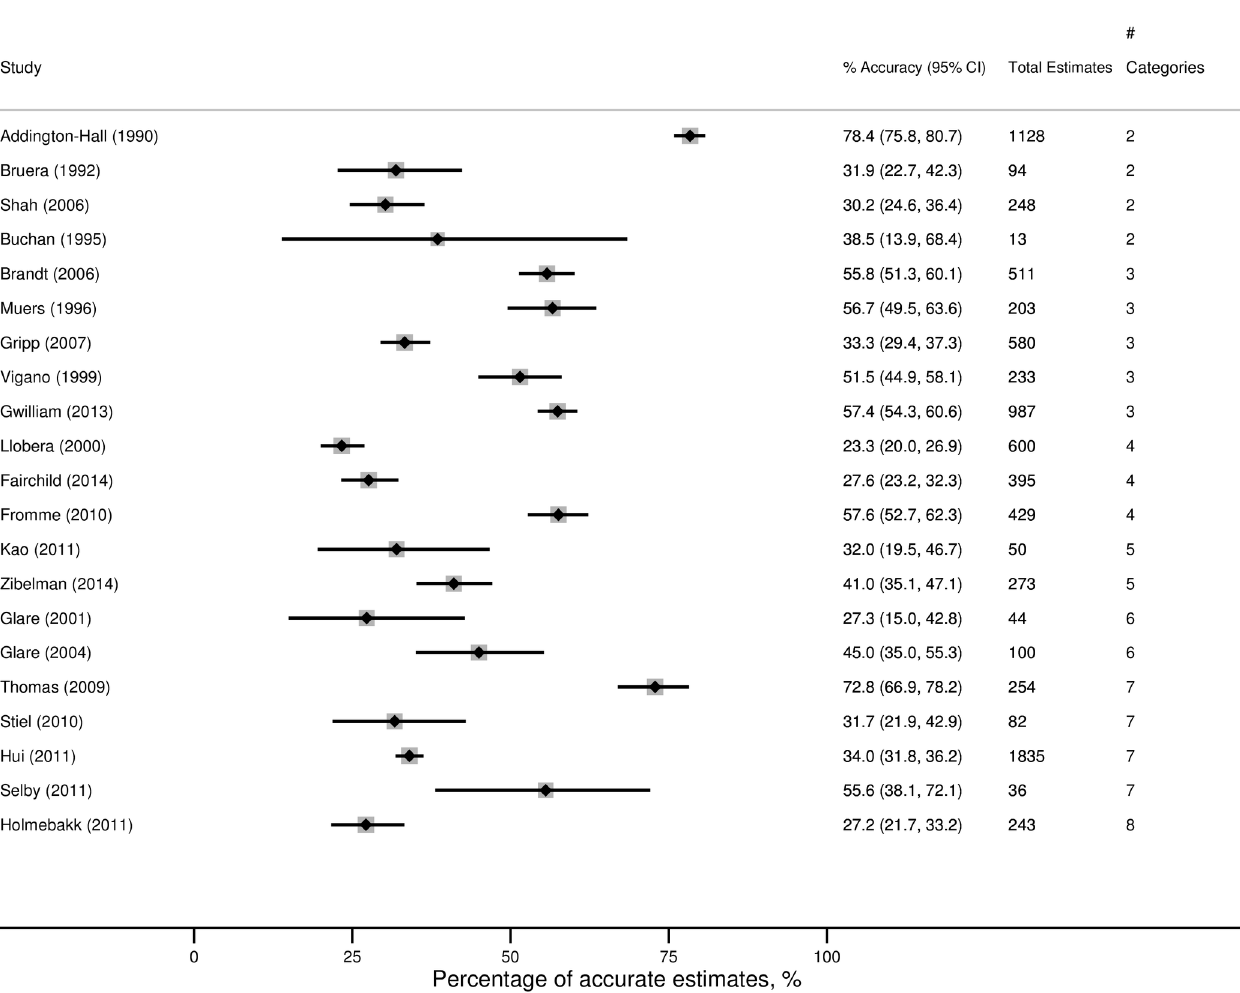
Fig 2. Summary data from studies in which clinicians provided categorical survival estimates (grouped by number of categories). The data represented is the percentage of accurate estimates given out of the total number of estimates given. Note: The study by Gwilliam et al (2013) included doctor, nurse and MDT estimates. However, since the estimates were not independent of each other, only the MDT estimates have been presented here.